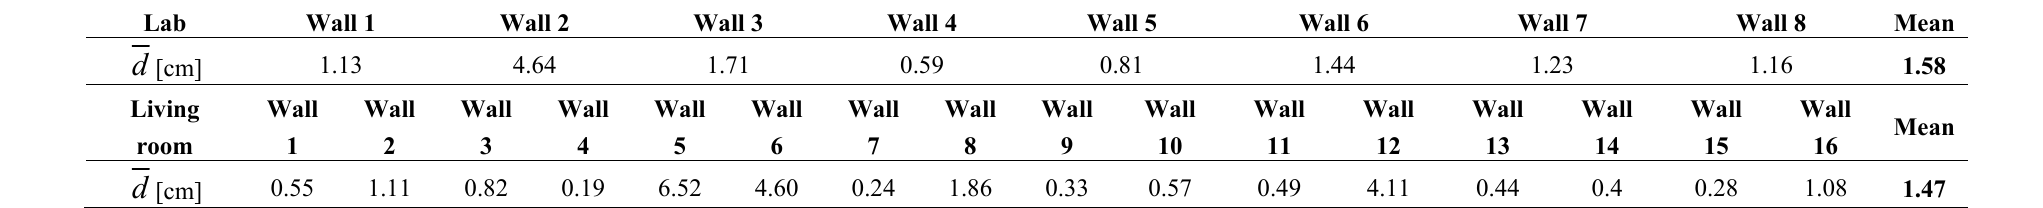
Table 1. Mean deviation of the scanned data to fitted walls.